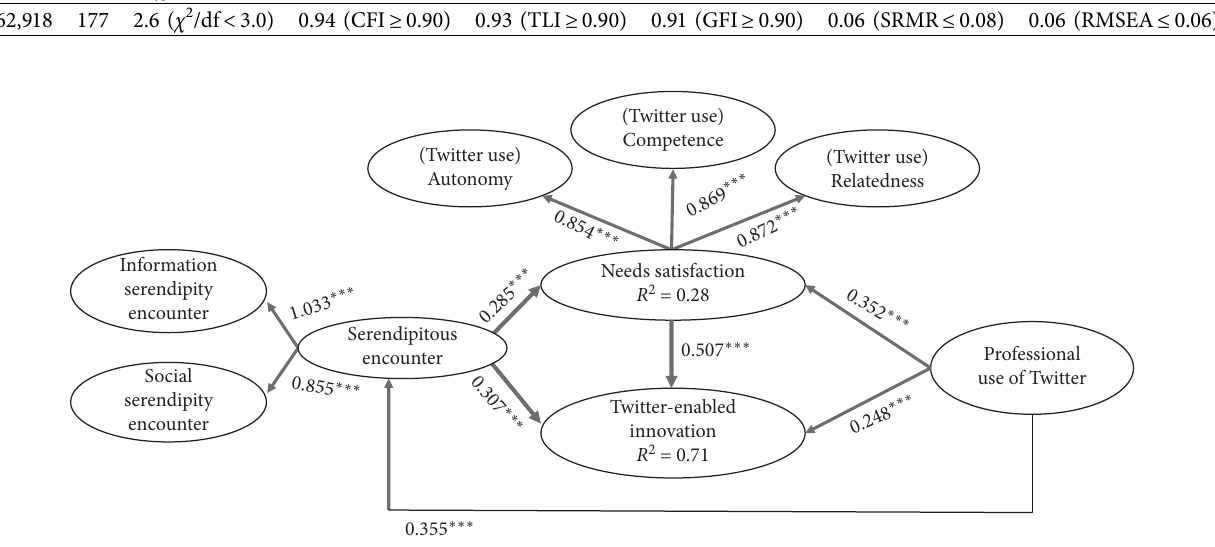
Figure 2: Model results ( ∗∗ ∗ p < 0 .